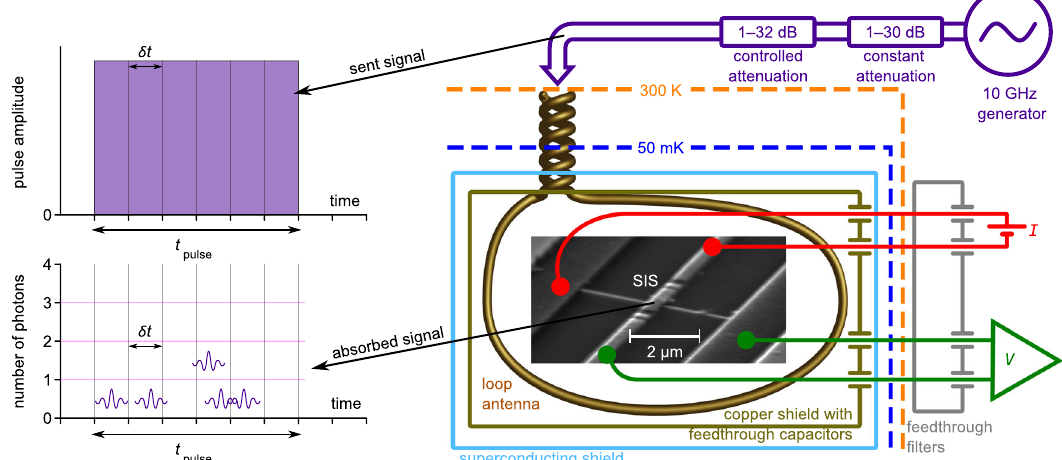
Fig. 1 The scheme of the measurement setup with thermal mounting and two fi ltering stages. The sample was mounted in an RF-tight box with superconducting shielding on the 10 mK cryostat plate. The DC bias wires were fi ltered with feed-through capacitors at room temperature and RC fi lters at the 10 mK plate, minimising the effect of low-frequency noise. A pulse of 10 GHz signal after a two-stage attenuation at room temperature was further attenuated by 30 dB by the twisted pair and sent to the loop antenna, weakly coupled to the sample. The coupling ef fi ciency and the power received by the SPC was measured in situ. In such a setup, a classical pulse (violet rectangle) was attenuated until it was absorbed by the SPC as separate photons during the response time δ t , see the experimental study a SIS junction with a small critical current of only 23 nA, expecting high single-photon sensitivity due to the lower threshold, with a trade-off of decreasing the dark count time.